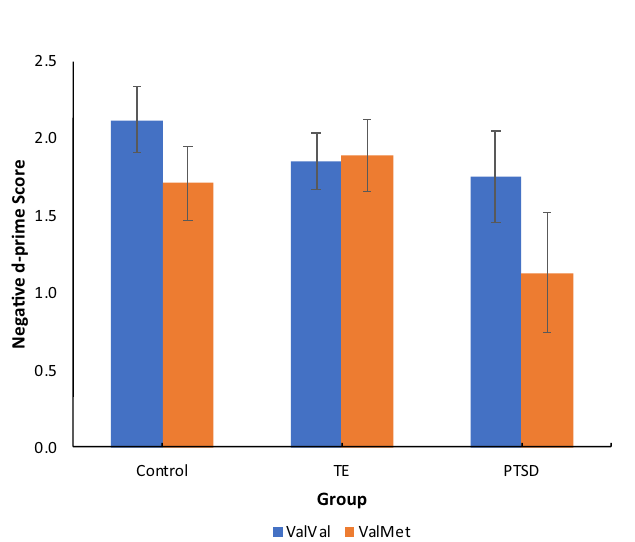
Figure 1. Mean d-prime scores for total recognition memory across the PTSD, TE and control groups. Error bars display: 95% confidence intervals.